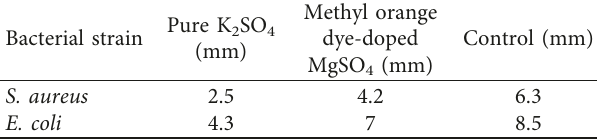
Table 2: Bacterial activity of pure and doped K